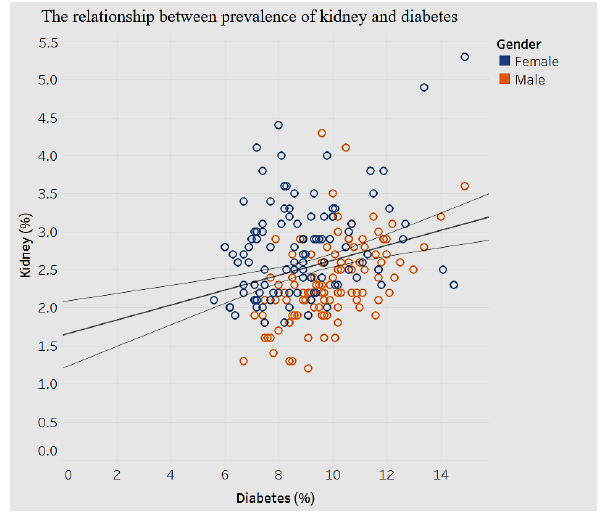
Figure 24. Diabetes by kidney disease.